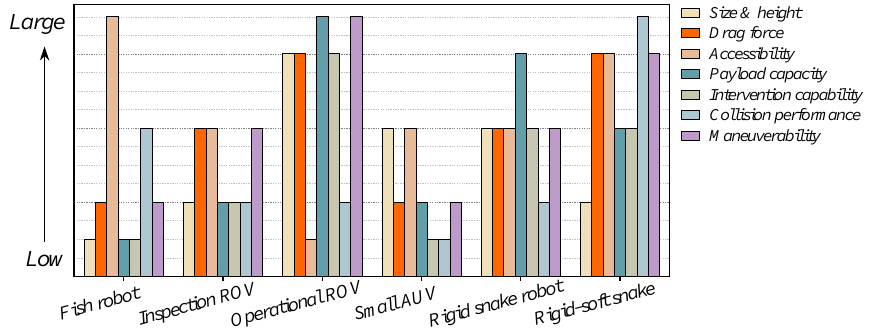
Figure 1. Comparison of various characteristics of common underwater vehicles.